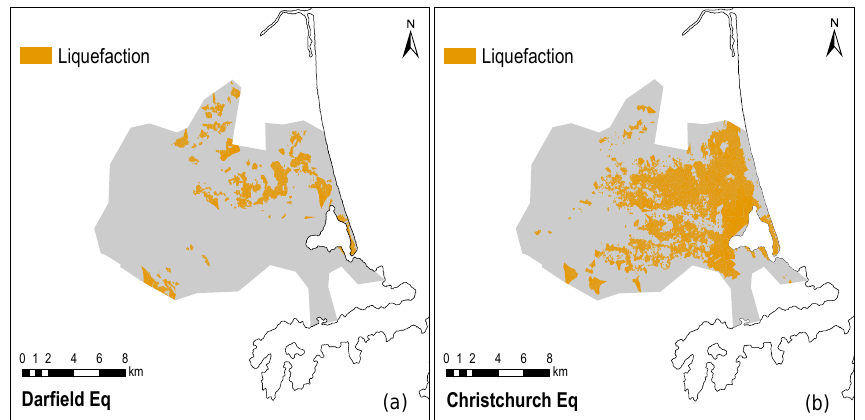
Figure 3. Location of surface liquefaction observations (brown) in Christchurch and surrounding areas due to the Darfield and Christchurch earthquakes, based on data provided by Tonkin and Taylor and published within the Canterbury Geotechnical Database